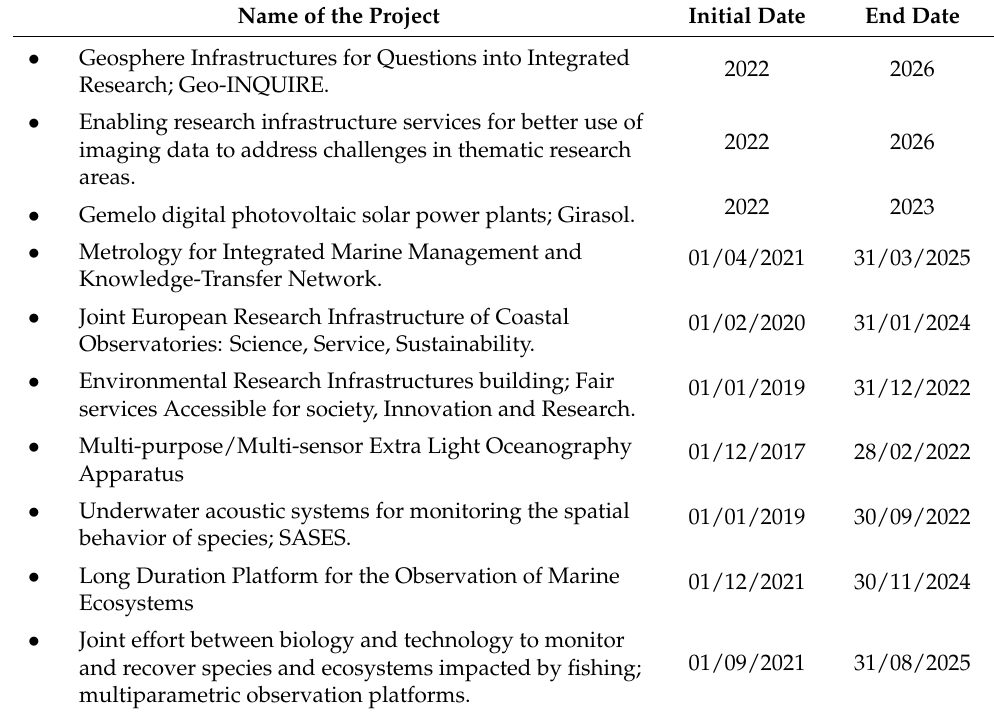
Table 17. Currently active research projects with funding for competitive public calls